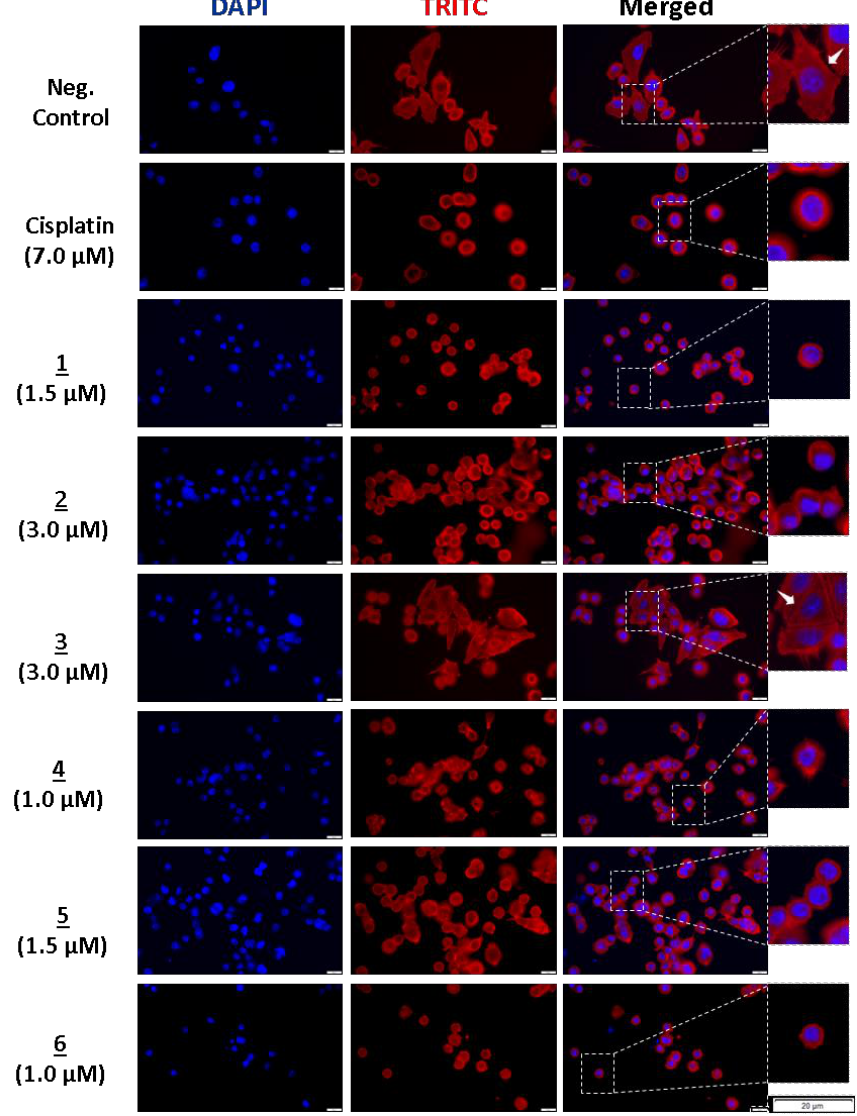
Figure 10. ‘FeCp’ compounds affect the cytoskeleton of SW480 colorectal cancer-derived cell line. The analysis of F-actin staining was performed using the IC 50 values of each compound, for 48 h. Representative images (×600) of DAPI (4’,6-diamidino-2-phenylindole), Phalloidin-AlexaFluor® 568 and merged were obtained in a fluorescence microscope. The results were obtained from at least three independent experiments.